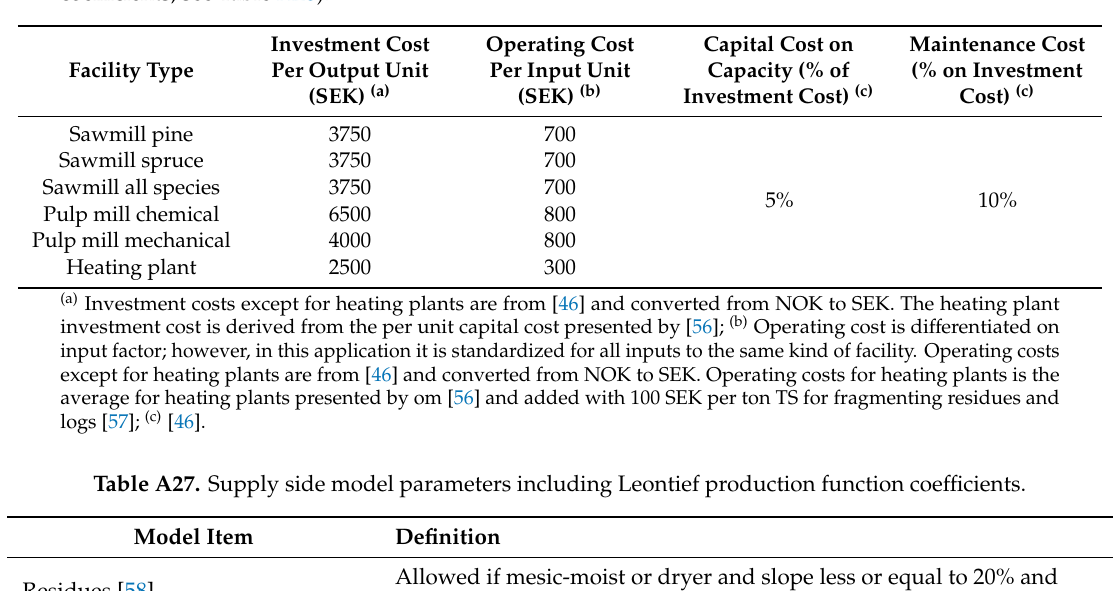
Table A26. Parameters associated with di ff erent facility types (for Leontief production function coe ffi cients, see Table A28).